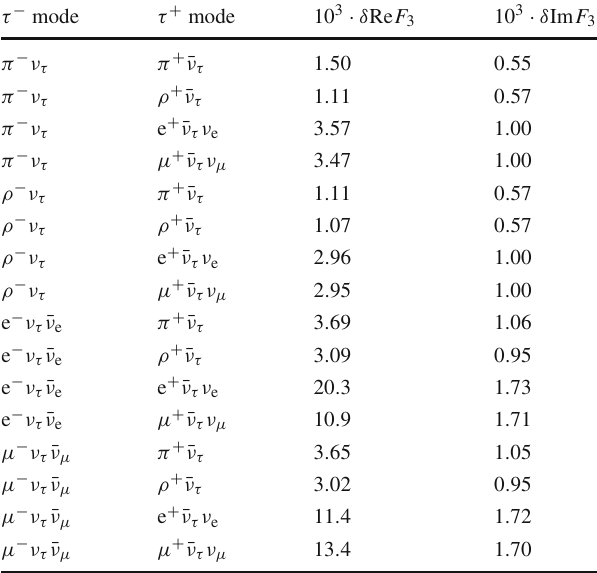
Table 2 Results from 10 6 simulated events for the resolutions of Re F 3 and Im F 3 in the 16 possible combinations of decay